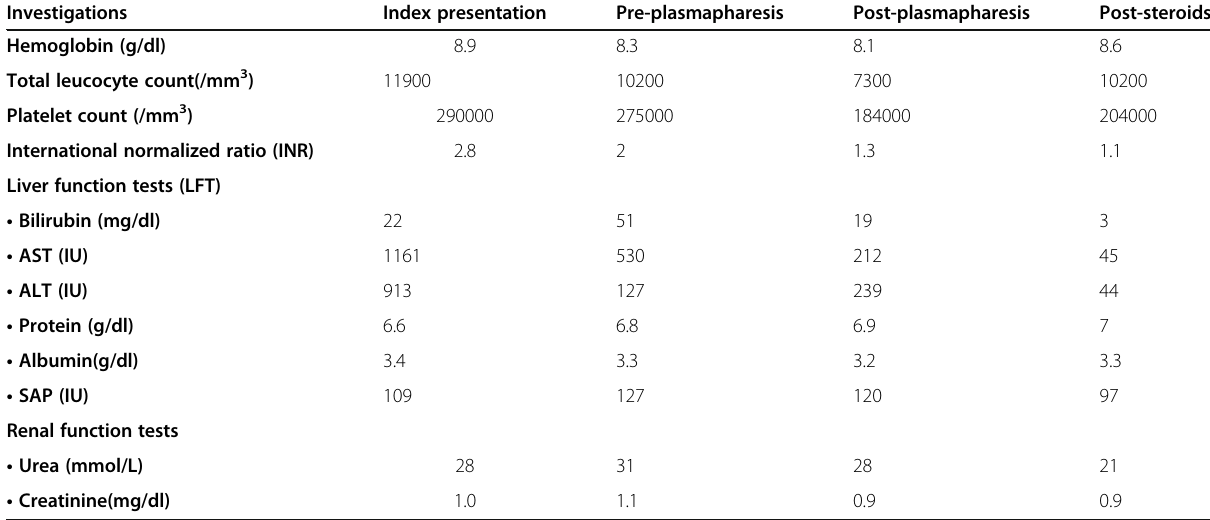
Table 1 Hematological and biochemical parameters